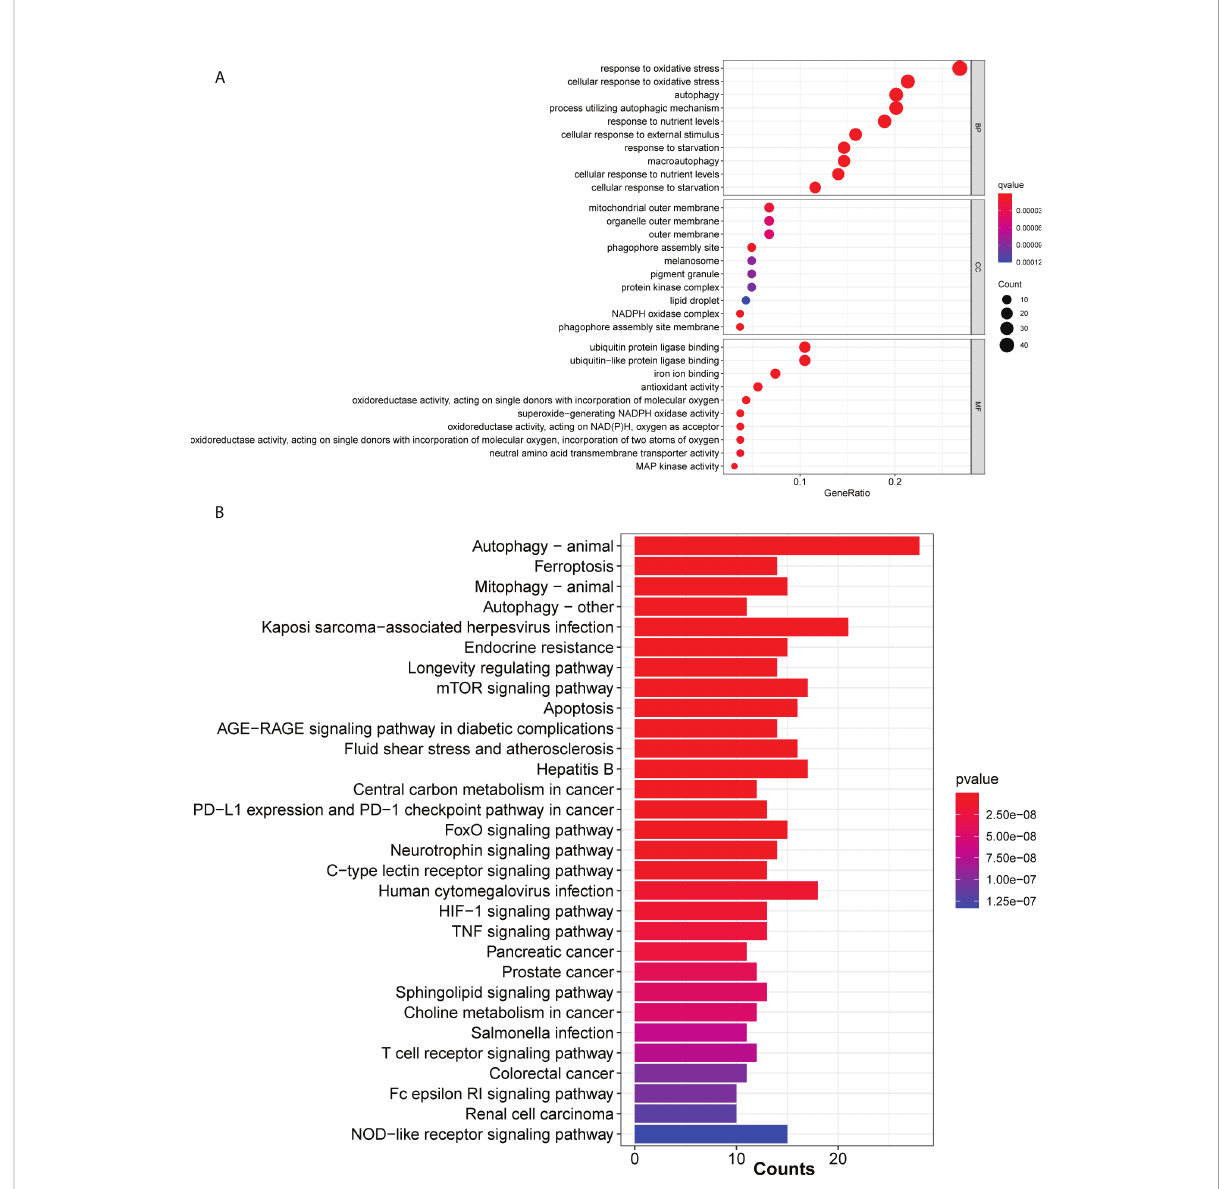
FIGURE 1 Ferroptosis-associated mRNAs in The Cancer Genome Atlas cohort. (A) Bar and (B) cluster plots of signi fi cantly enriched Gene Ontology and Kyoto Encyclopedia of Genes and Genomes pathways, respectively, are